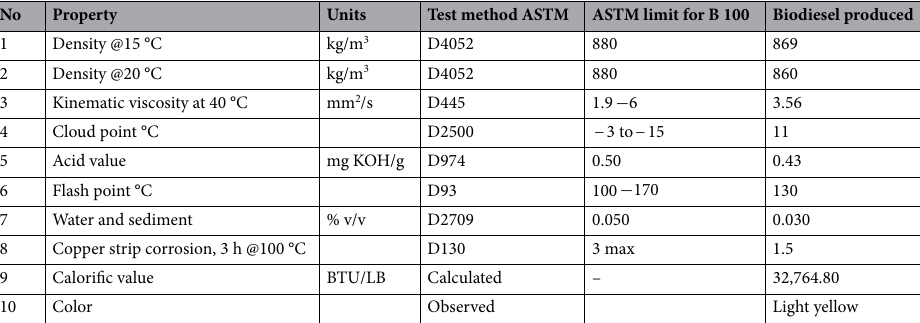
Table 5. Physicochemical characteristics of the biodiesel produced from